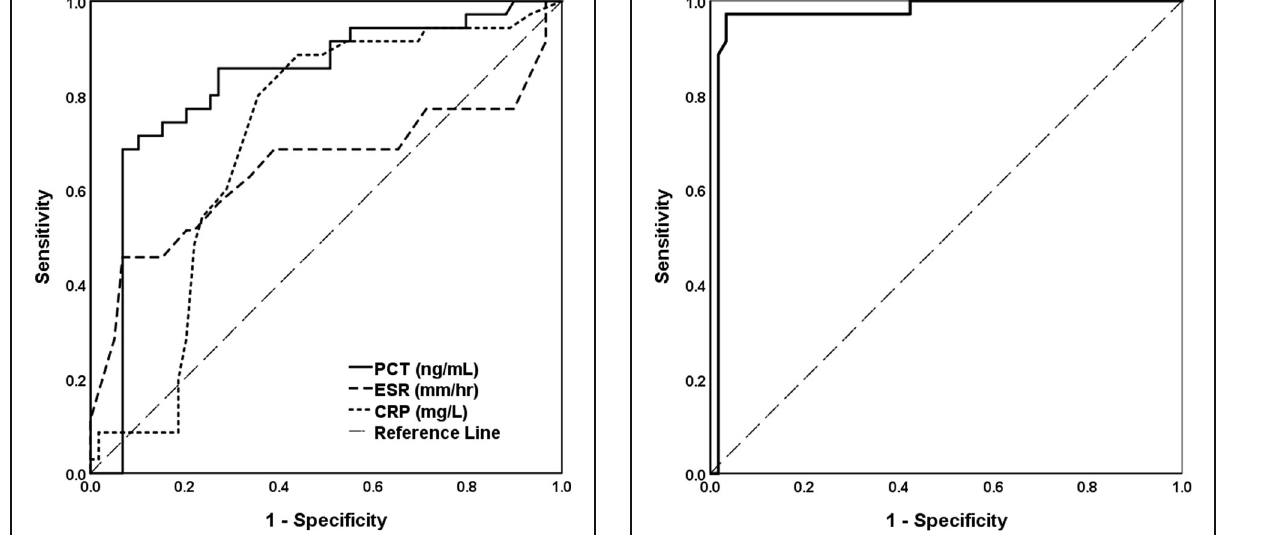
Fig. 4 Sensitivity and specificity of serum PEC index for discriminating culture-negative SBP from sterile